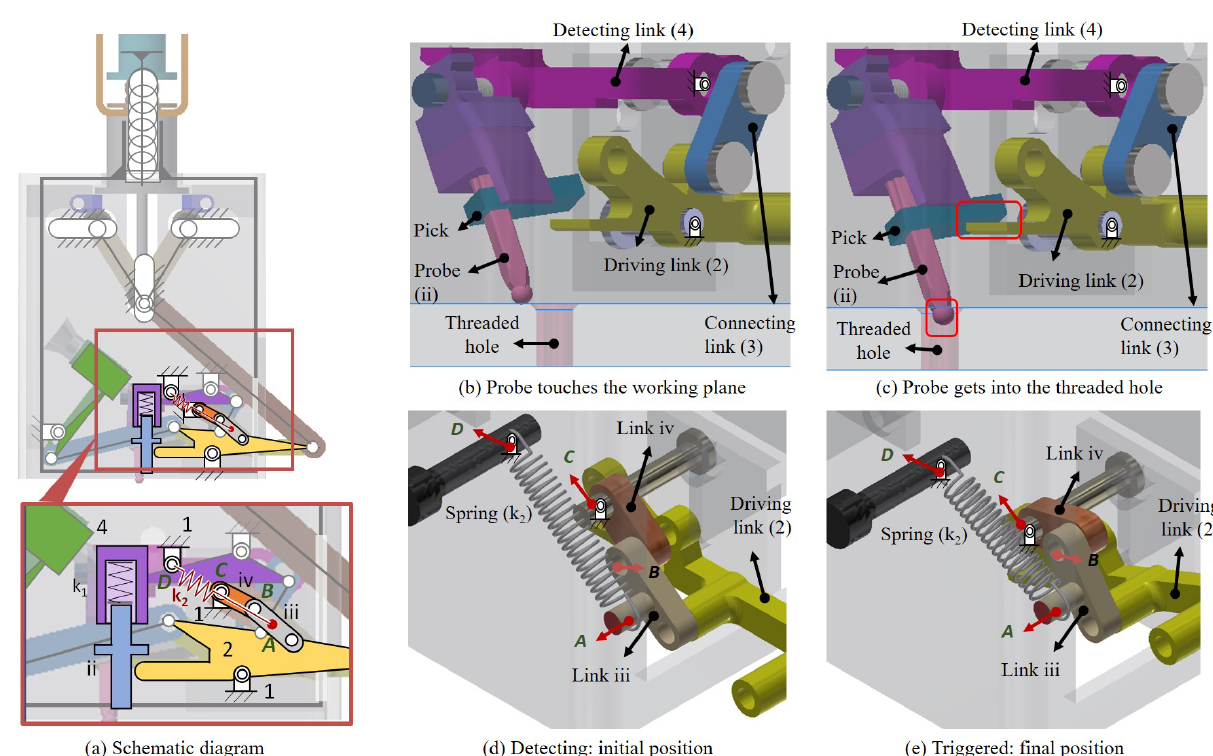
Figure 4. Trigger